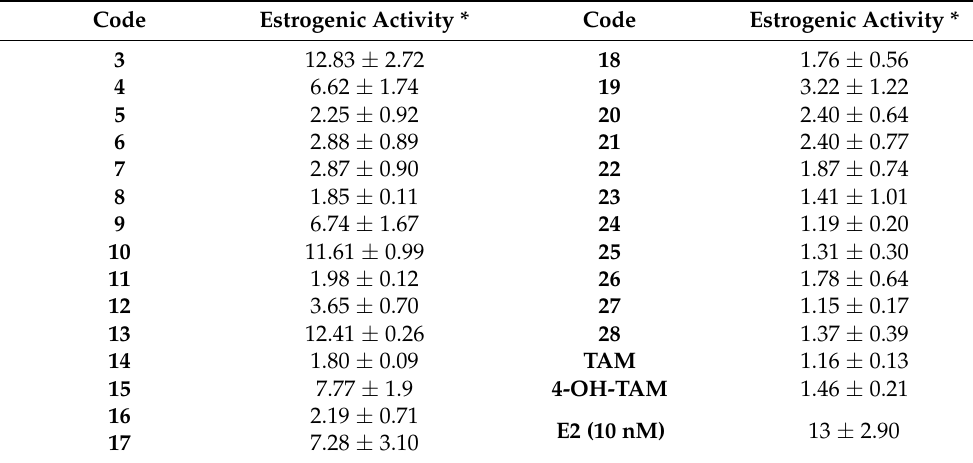
Table 3. Relative β -galactosidase activity using YES assay (agonistic